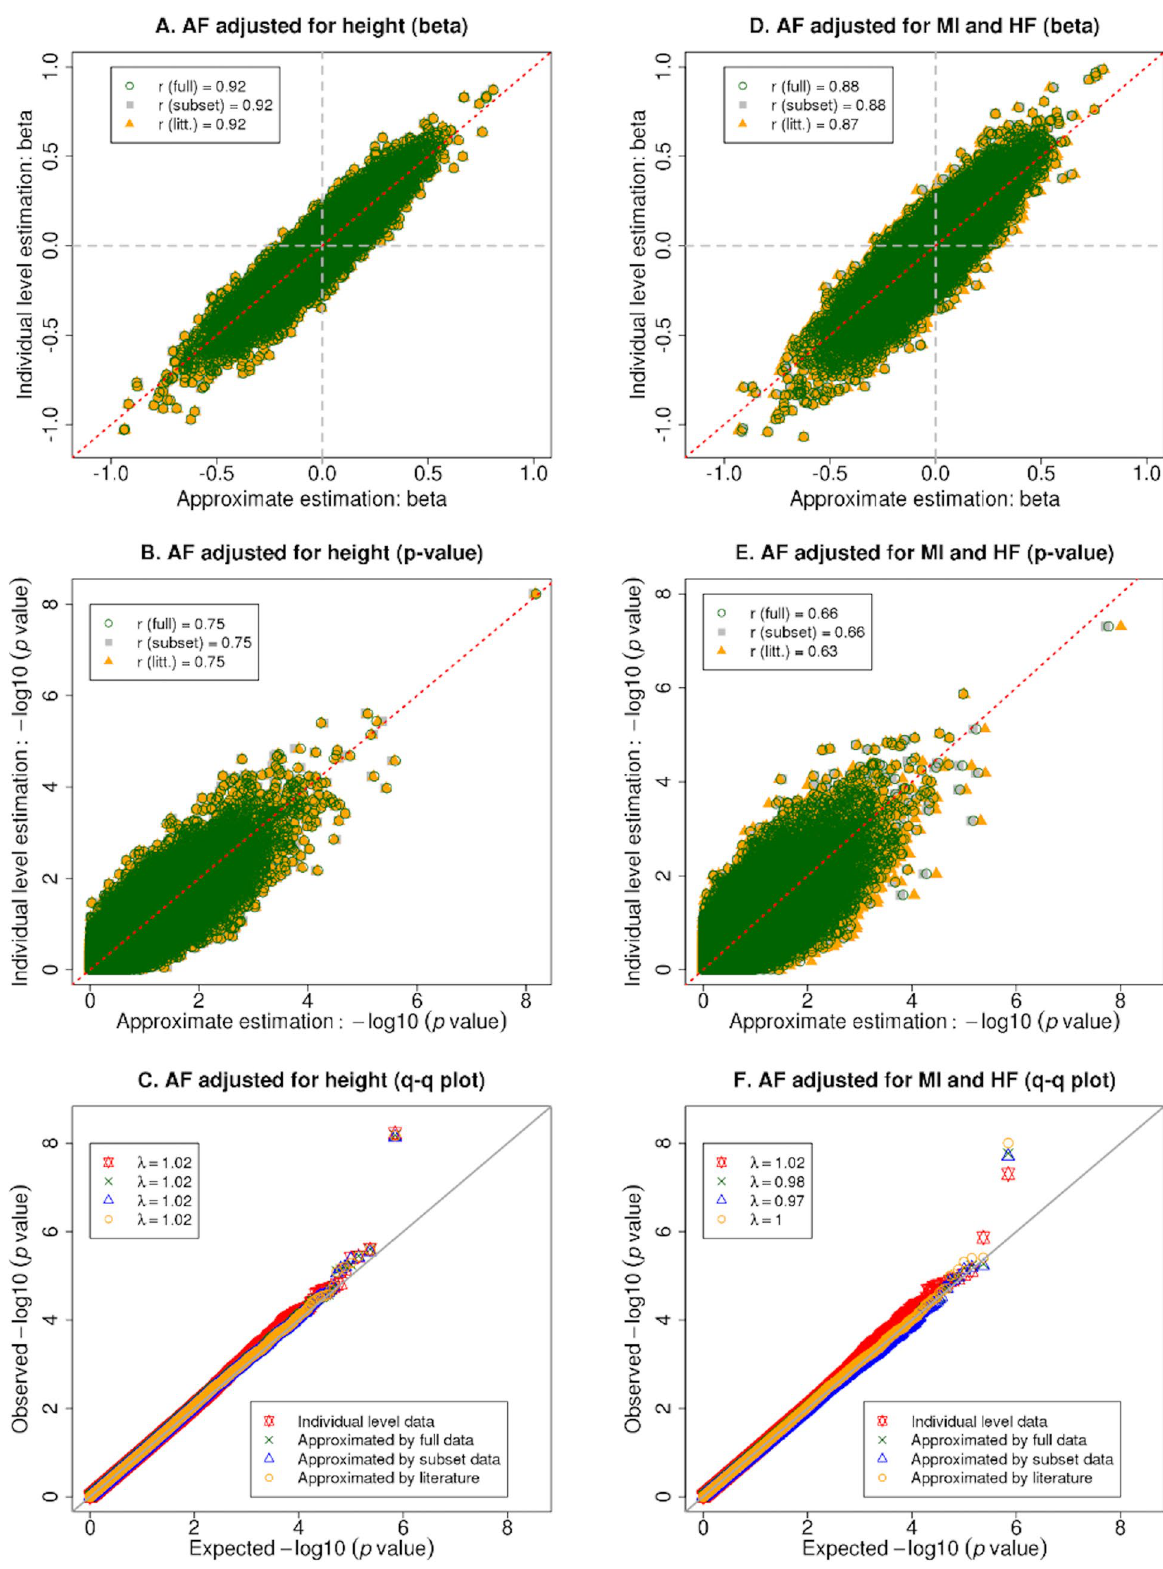
Figure 3. Estimated effect sizes, − log10 (p-values) and quantile–quantile plots for GWAS results with binary outcomes measured in the Framingham Heart Study. Panels ( A – C ) present estimated effect sizes, − log10 (p-values), and quantile–quantile plot (q-q plot), respectively, for GWAS results from analyzing atrial fibrillation (AF) adjusted for height; panels ( D – F ) present the estimated effect sizes, − log10 (p-values), and q-q plot, respectively, for AF adjusted for both myocardial infarction (MI) and heart failure (HF). Individual level data analysis is the gold standard for estimation, “full” means the relationship between the outcome and the covariate is estimated using a full sample of individuals, “subset” means the relationship is estimated using a random subset of 1,000 individuals, and “litt.” or literature means the relationship is taken from published reports 10,11